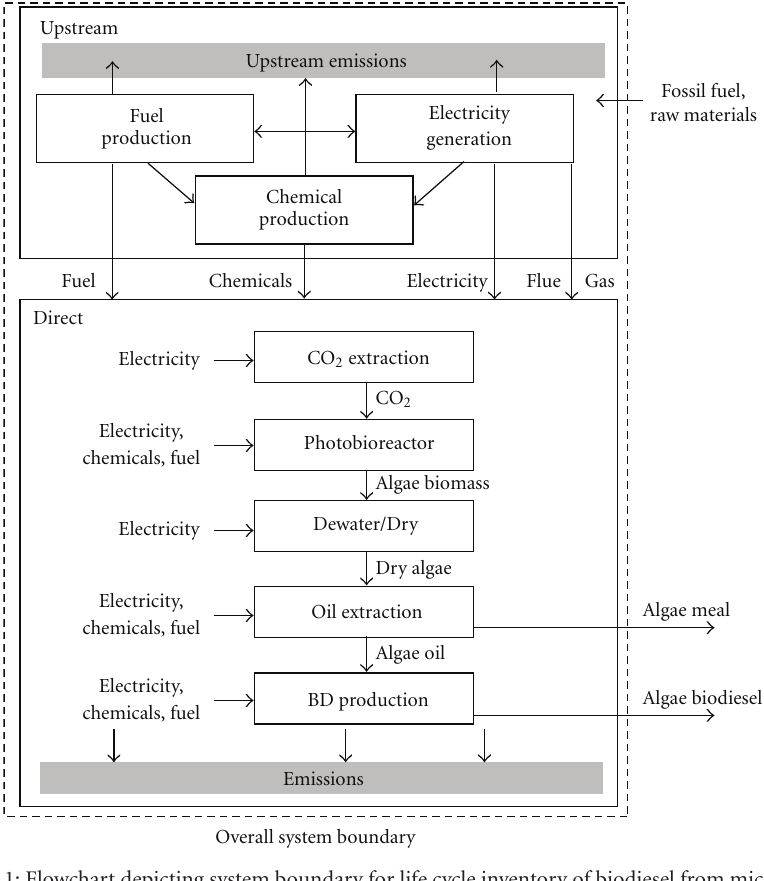
Figure 1: Flowchart depicting system boundary for life cycle inventory of biodiesel from microalgae.